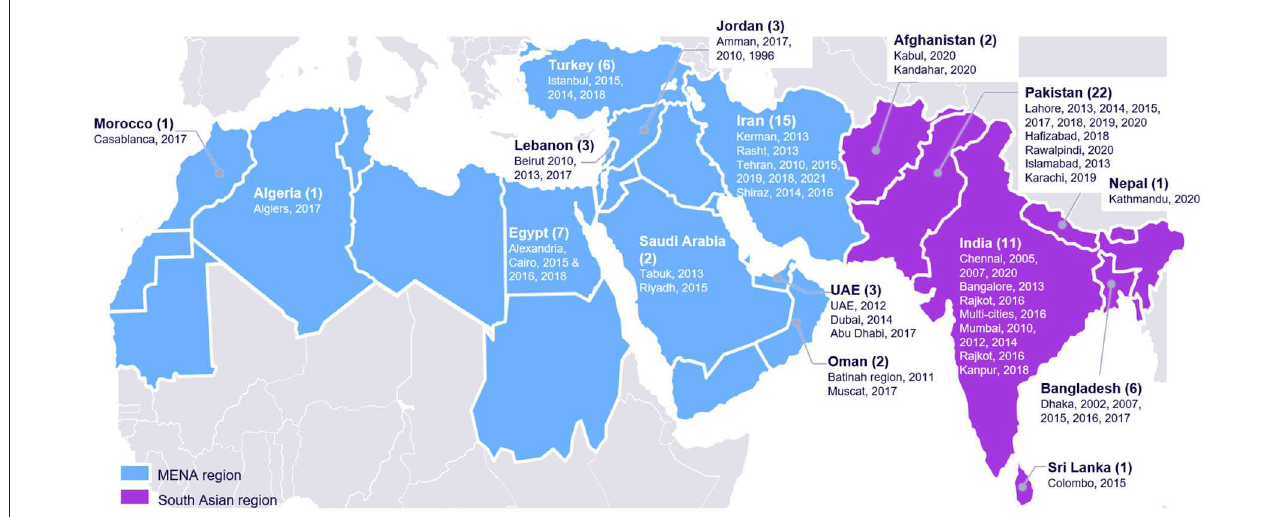
FIGURE2 Overview of previous published studies for cities in MENA and SA